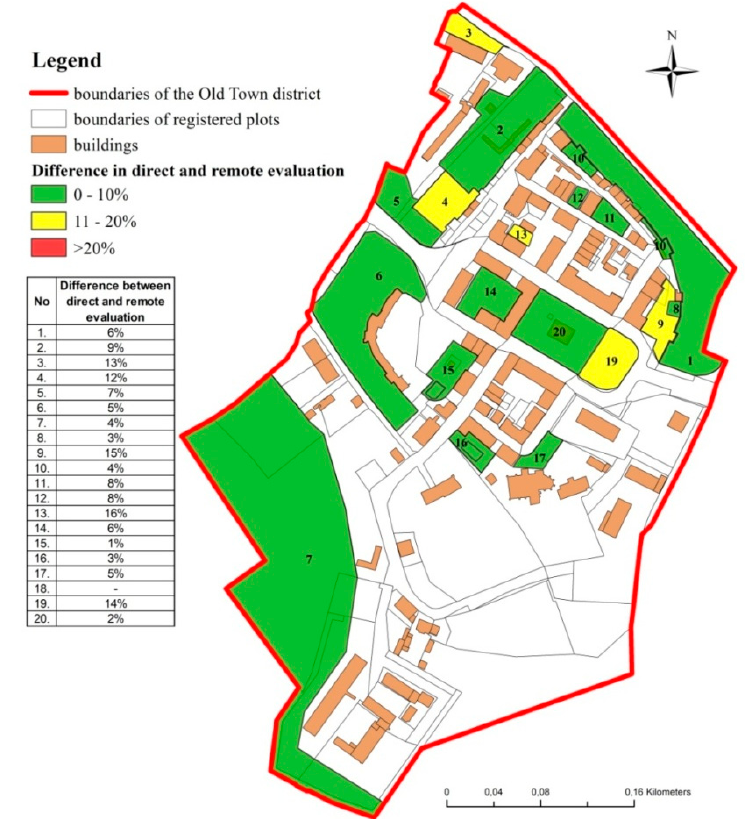
Figure 5. Average differences in the quality of public space elements evaluated in the direct and the remote approach in Mor ą g. Source: own elaboration.